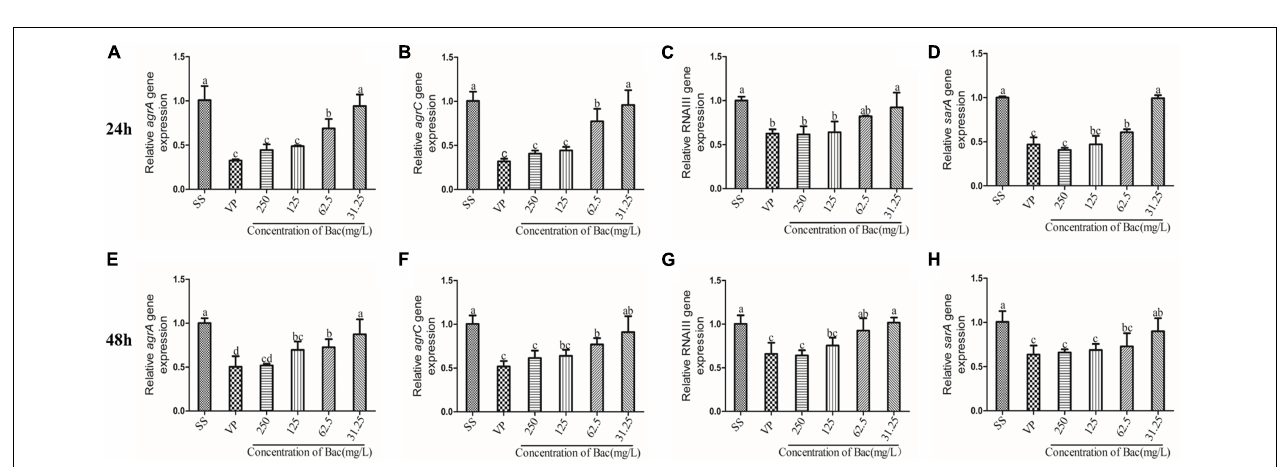
FIGURE 8 | Influence of msrA gene relative expression in biofilm bacteria of baicalin (using 16S rRNA as the internal parametric gene). The relative expression of the msrA gene was determined in samples prepared from 24 h (A) and 48 h (B) ARSS biofilms in BHI using quantitative RT-PCR. Data are derived from three biological repeats. Bars in the same index without the same letters differ significantly ( p < 0.05).